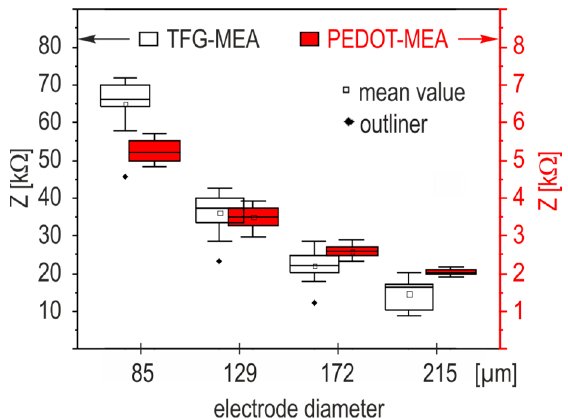
Figure 4. Box plot of impedance magnitude (1 kHz) as a function of the electrode diameter. Planar MEAs with TFGe are referred to as TFG-MEAs. MEA chips with PEDOT are referred to as PEDOT-MEA.